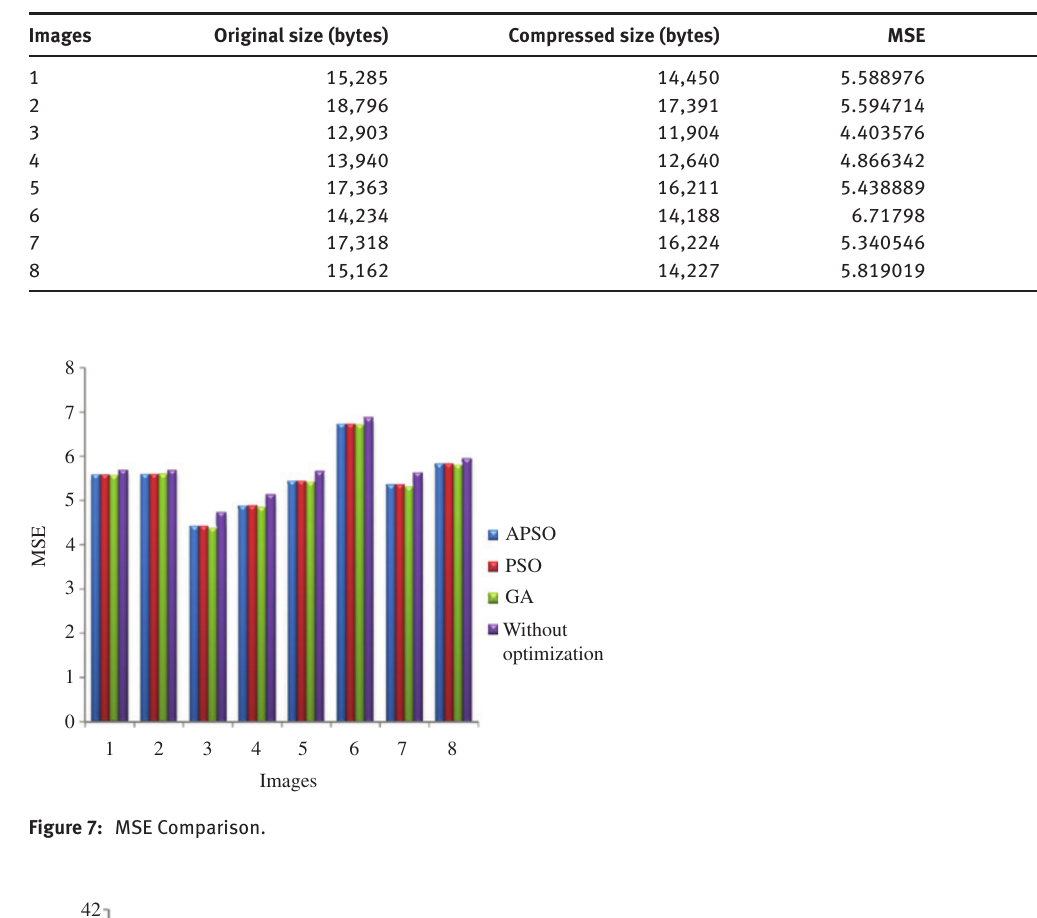
Table 2: File Size Comparison for Proposed Method.